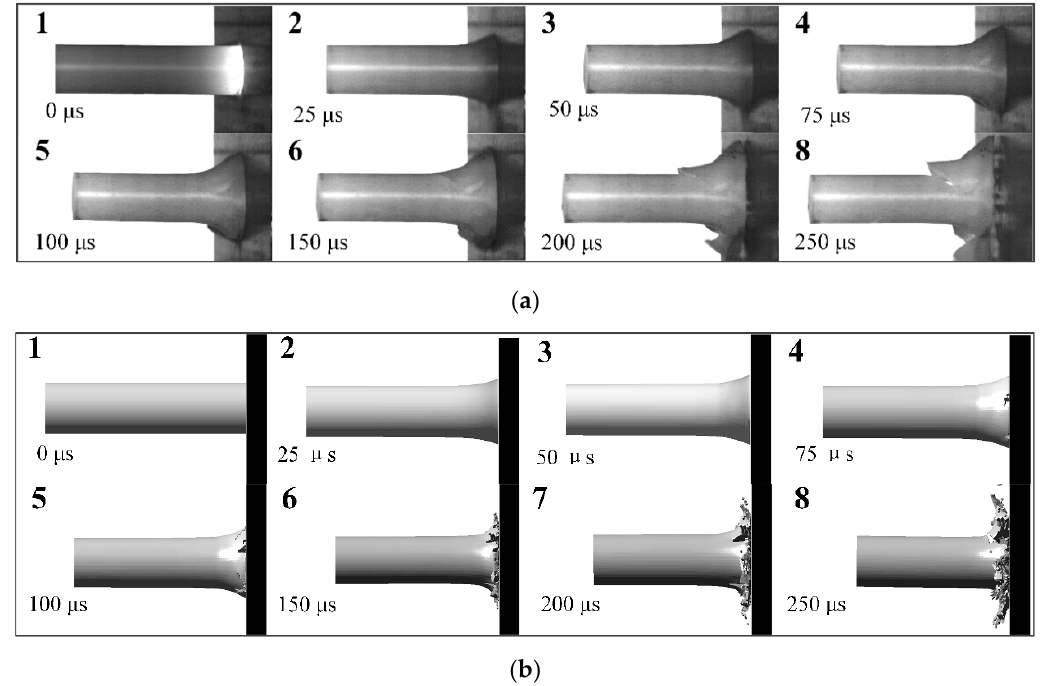
Figure 11. Taylor test at 168 m/s: ( a ) high-speed photographs; ( b ) deformation predictions using 3D simulation.